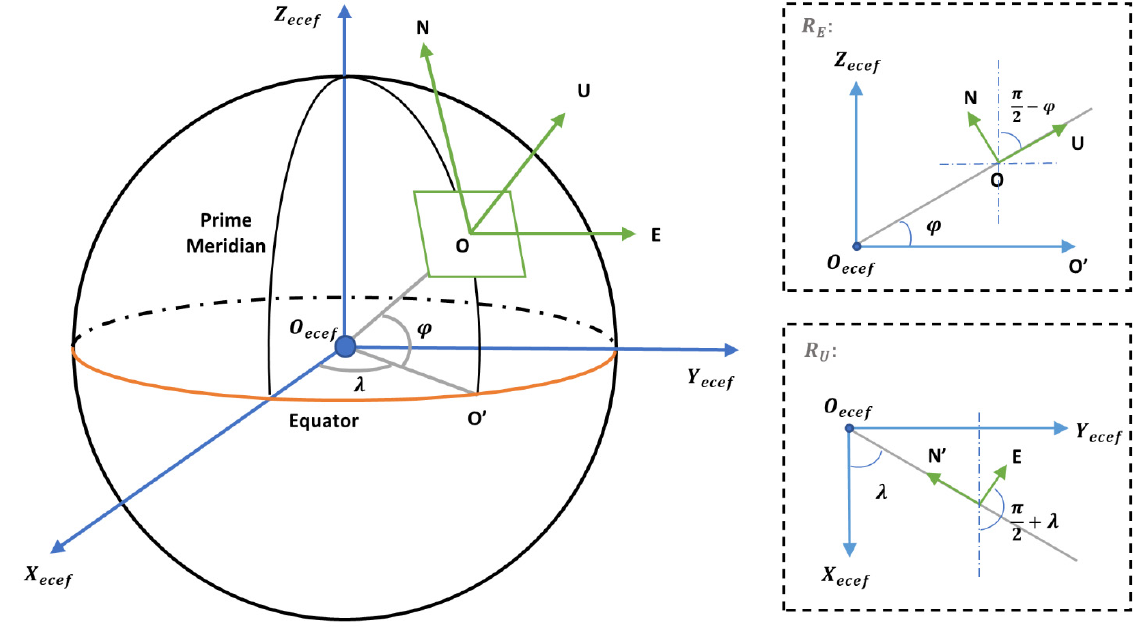
Figure 10. The relationship between the ENU frame and the ECEF frame, and the schematic diagram of the rotation is on the right of the figure.